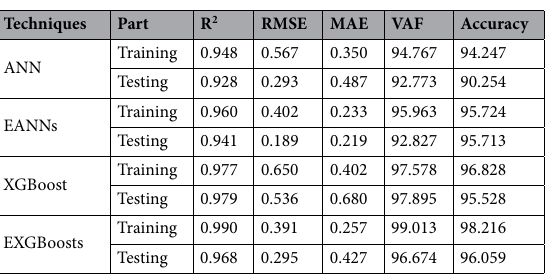
Table 8. Performance of the ensemble and the best individuals of ANN and EXGBoosts.